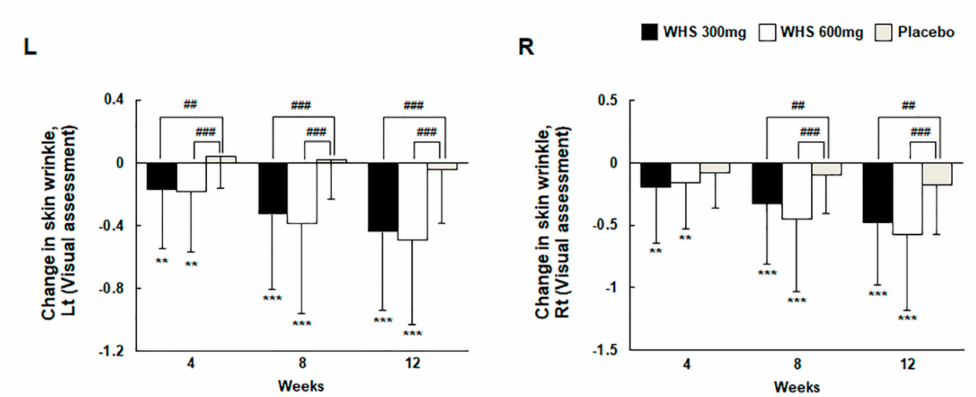
Figure 2. Changes in skin wrinkle (visual evaluation) in the Hydrangea serrata leaves (WHS) 300 mg